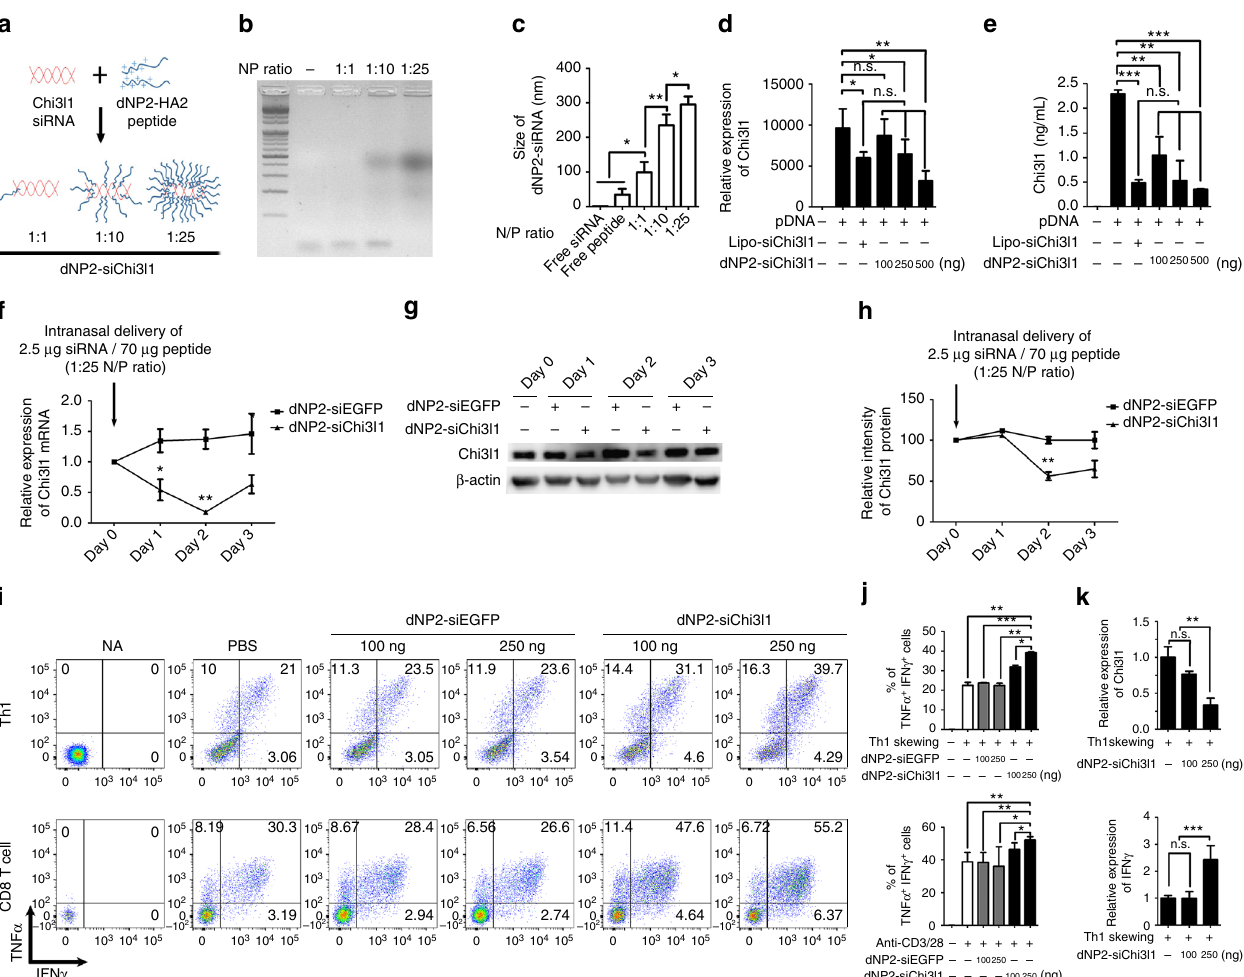
Fig. 8 Targeted inhibition of Chi3l1 by dNP2-siChi3l1 complex enhances effector cytokine production in Th1 and CD8 T cells. a Schematic diagram of the complex formation of dNP2-HA2 peptide and Chi3l1 siRNA (siChi3l1) at indicated N/P ratios. b Gel retardation assay of dNP2-siChi3l1 complex. c The size of free siRNA, free peptide, and dNP2-siRNA complexes were measured by Nano particle size analyzer. d Dose dependent reduction of Chi3l1 mRNA expression by dNP2-siChi3l1 complex at 1:25 N/P ratio. e Chi3l1 protein level in culture supernatants were measured by ELISA. f Chi3l1 mRNA in the lung after intranasal administration of dNP2-siEGFP or dNP2-siChi3l1 complex at 1:25 N/P ratio. Chi3l1 mRNA normalized to β -actin, and presented as relative to expression at day 0. g Chi3l1 protein level in the lung was analyzed by Western blotting. Chi3l1 protein relative to expression at day 0. h Densitometric values of band intensity was calculated by normalization to the value of β -actin, then the value was represented as relative to the value at day 0. Statistical signi fi cance of dNP2-siChi3l1 treated group was analyzed to dNP2-siEGFP treated group on each day. i FACS-sorted WT naïve CD4 T cells were differentiated into Th1 cells and WT naïve CD8 T cells were activated by plate-bound anti-CD3 and anti-CD28 antibodies with IL-2 for 5 days with indicated concentrations of dNP2-siEGFP or dNP2-siChi3l1 complexes. IFN γ and TNF α expression were analyzed by fl ow cytometry. j % of TNF α + IFN γ + cells were represented as bar graph. k Chi3l1 and IFN γ mRNA expression in dNP2-siChi3l1 treated Th1 cells. Each gene expression level was normalized to β -actin, and represented as fold change to those of WT Th1 cell. Data are presented as mean ± SD of three sets of independent experiments ( n = 6). n.s., not signi fi cant; * p < 0.05, ** p < 0.01, *** p < 0.001 (two-tailed Student ’ s t